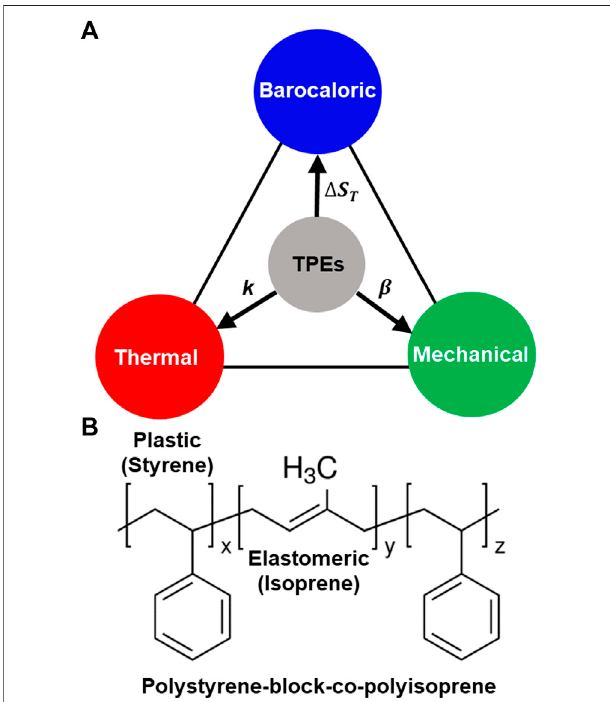
FIGURE 1 | Thermoplastic elastomers (TPEs) as promising barocaloric materials. (A) Different material properties relevant for solid-state refrigeration based on the barocaloric effect. These include compressibility ( β ), thermal conductivity ( k ), and barocaloric entropy change ( Δ S T ). (B) TPEs comprise a plastic and an elastomeric component — shown here for a typical block copolymer (polystyrene-co-block-polyisoprene).